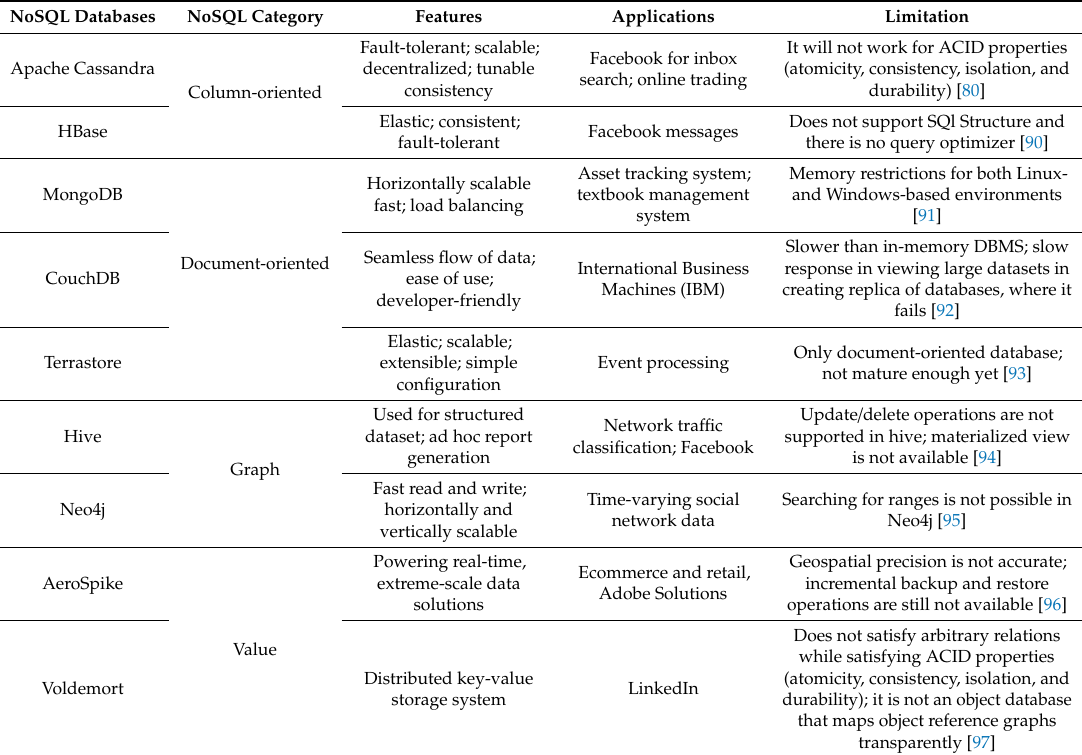
Table 8. Comparison of NoSQL data storage